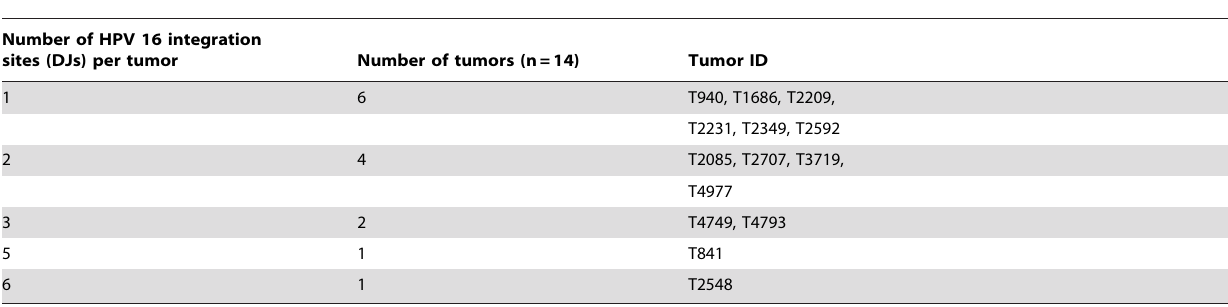
Table 3. Tumors with integrated HPV16 DNA, but without detected APOT fusion transcripts (TA-group 4).